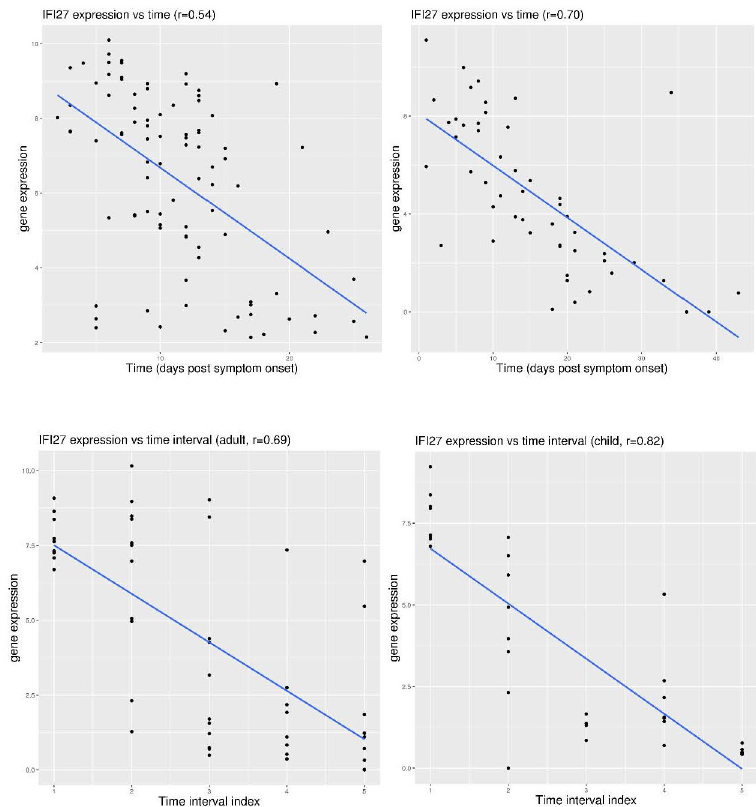
Fig 6. Correlation of IFI27 expression with the duration of COVID-19 infection. A) upper left (dataset Zenodo 6120249), correlation between IFI27 expression and time since symptom onset in COVID-19 patients. B) upper right (dataset GSE155454), correlation between IFI27 expression and time since symptom onset in COVID-19 patients. C) lower panel (dataset GSE166190), correlation between IFI27 expression and time interval index in COVID-19 patients (both adults and